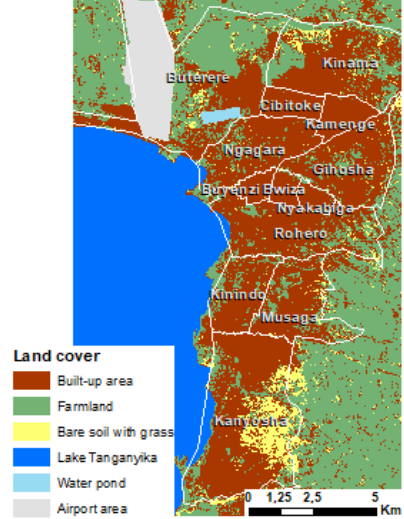
Figure 5. Land cover for 2017 from Landsat imagery